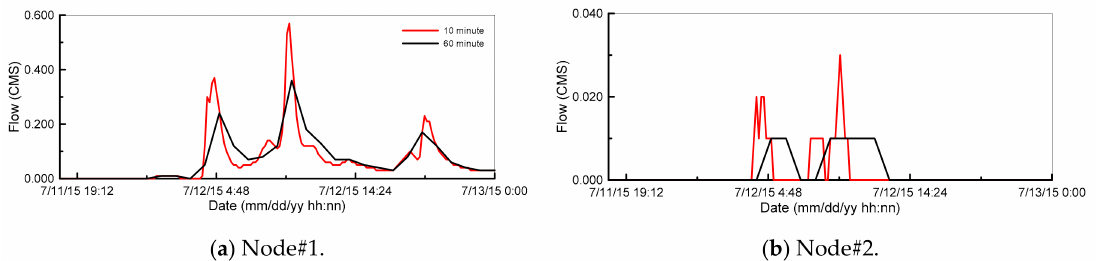
Figure 4. Comparisons of runoff simulated from precipitation data for 60-min periods directly recorded (black) and 60-min periods estimated from 10-min data: In this figure, Node# 1 and #2 indicate two of nodes (or junctions) in the SWMM-LID model for the application area. The unit, cms, means a cubic meter per